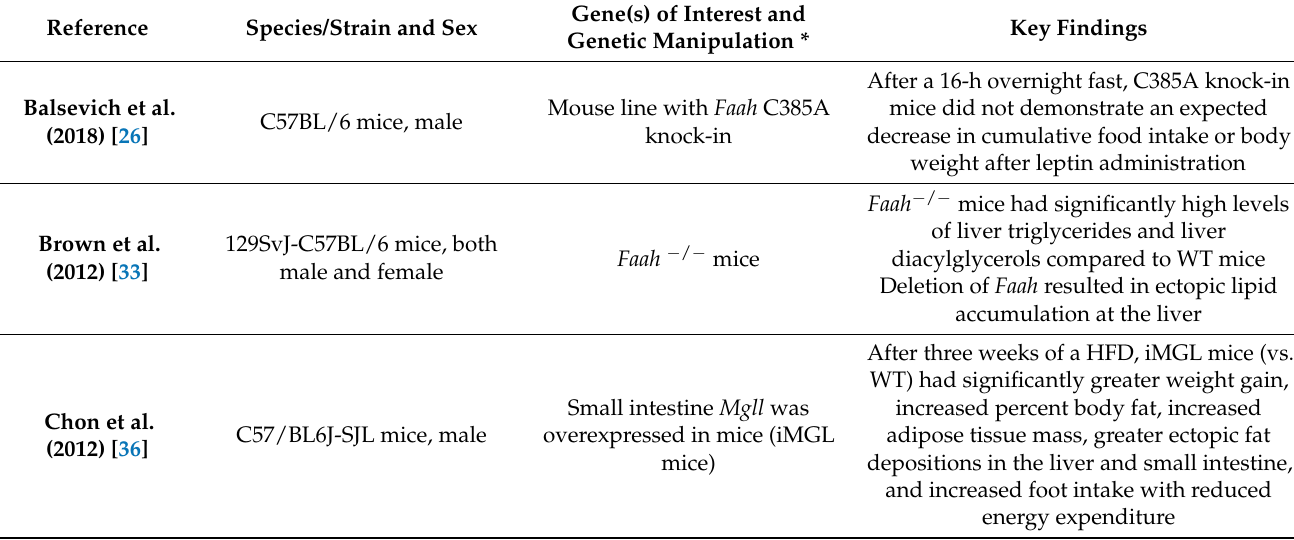
Table 2. Studies in animal models evaluating the impact of genetic manipulation of Faah or Mgll on obesity-related outcomes. Reference Key